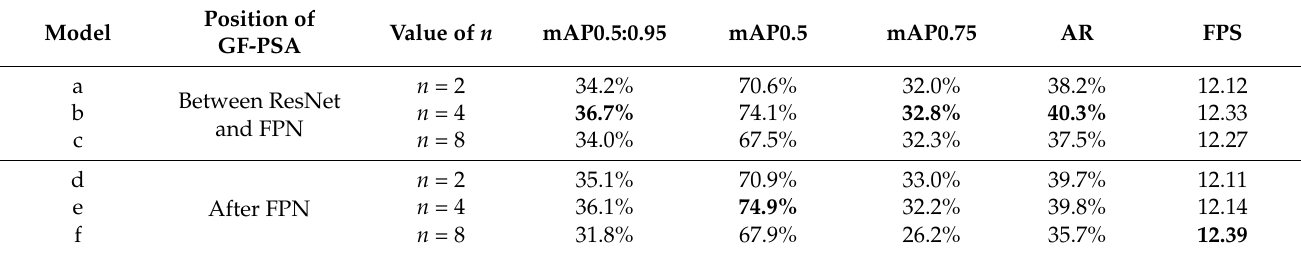
Table 4. Segmentation results on STSD dataset. FPS is evaluated using CUDA11.0 and CUDNN 8.2 on a Geforce RTX Graphics Card. The bold numbers represent the highest one of each indicator.